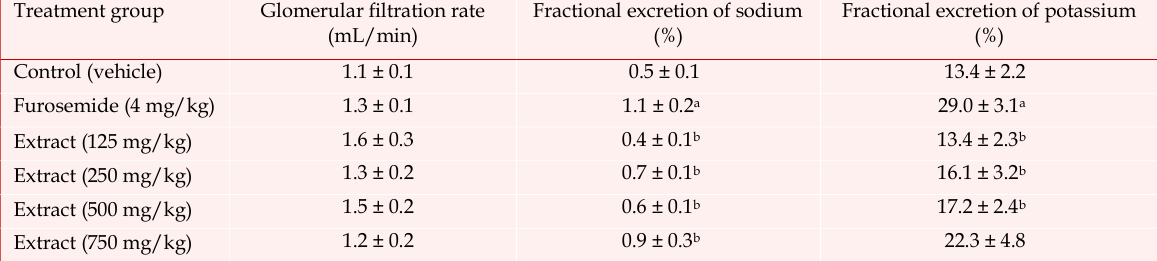
Effect of aqueous extract of E. polystachya on glomerular filtration rate, fractional excretion of sodium and